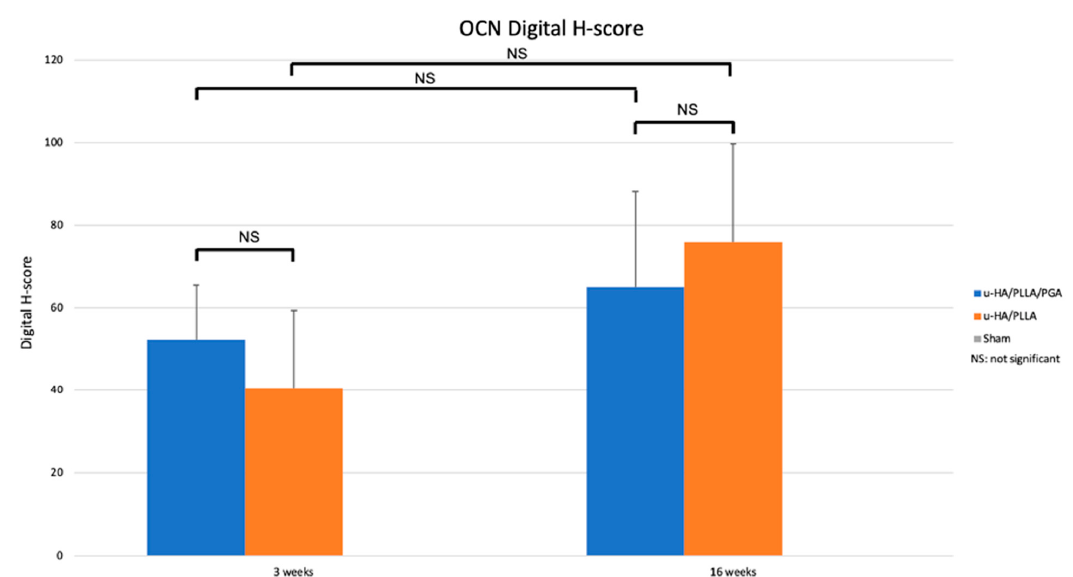
Figure 11. Digital H-scores based on IHC staining using an anti-OCN antibody in the u-HA/PLLA/PGA and u-HA/PLLA subgroups.